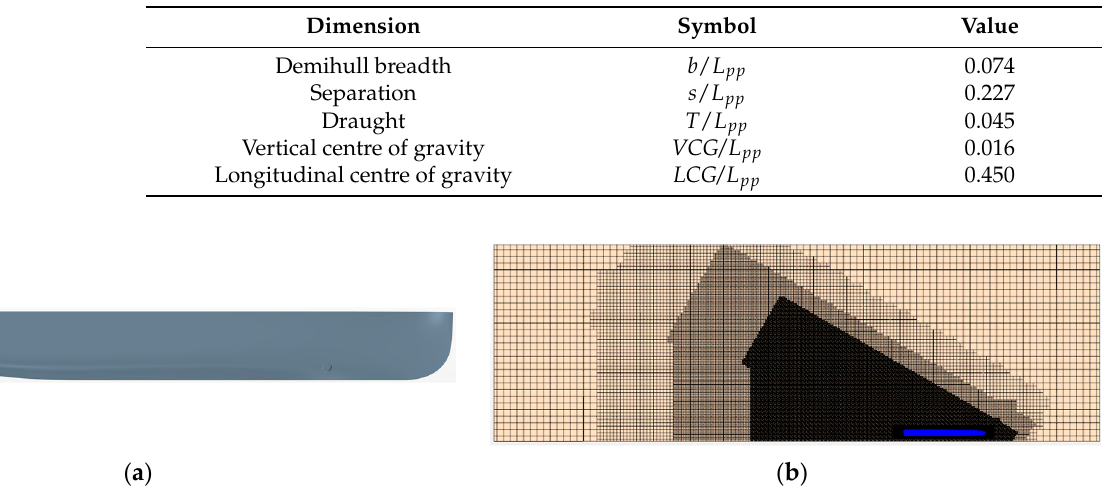
Figure 5. Total resistance coefficients ( a ), sinkage and trim ( b ) of NPL 4a02 model.